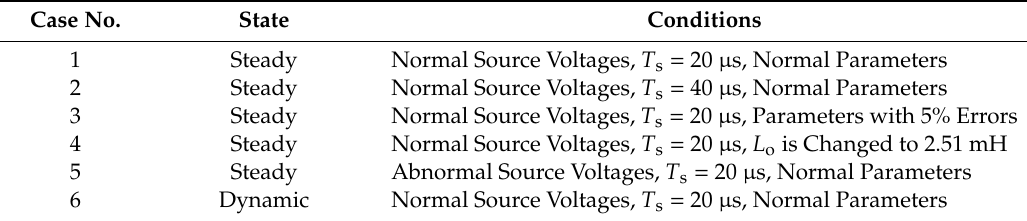
Table 4. Experimental conditions.